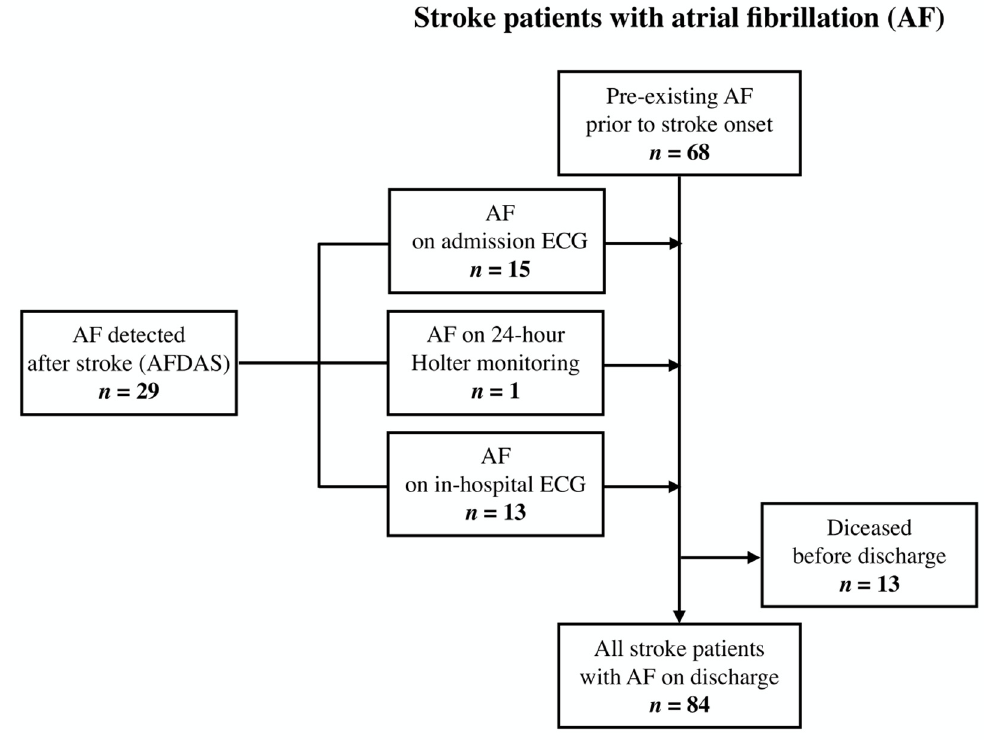
Figure 1. Flowchart of acute ischemic stroke patients with atrial fibrillation. Table 1. Demographic and clinical characteristics for stroke patients with and without atrial fibril- lation. Significant p -values are shown in bold.